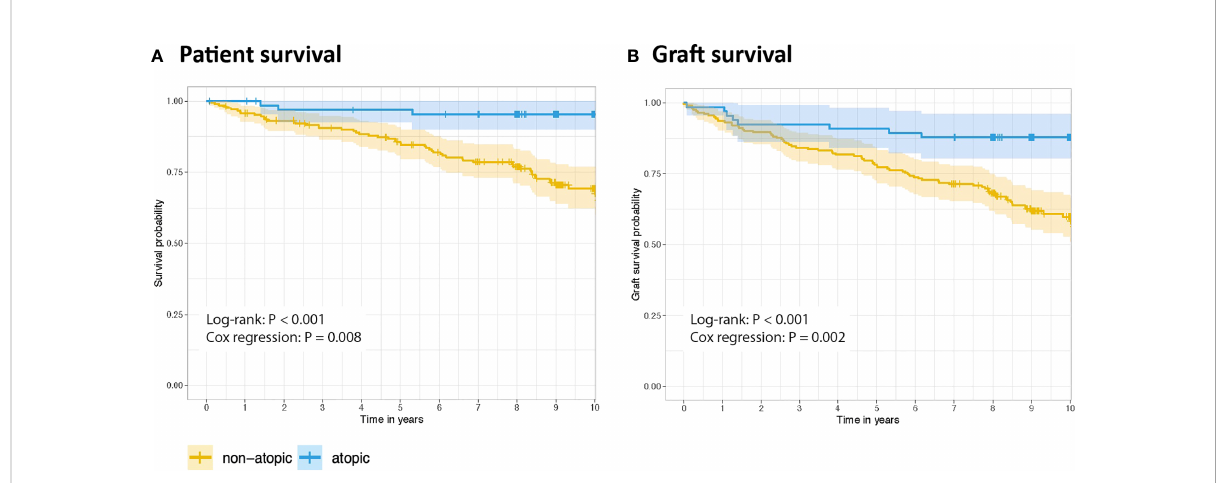
FIGURE 1 Kaplan-Meier estimates of ten-year follow-up. (A) Patient survival, and (B) kidney graft survival. The calculated p-values were obtained by the log-rank test (univariate analysis). Age-adjusted p-values were calculated with multivariate Cox proportional hazards regression analysis. 95% con fi dence intervals are represented according to the group